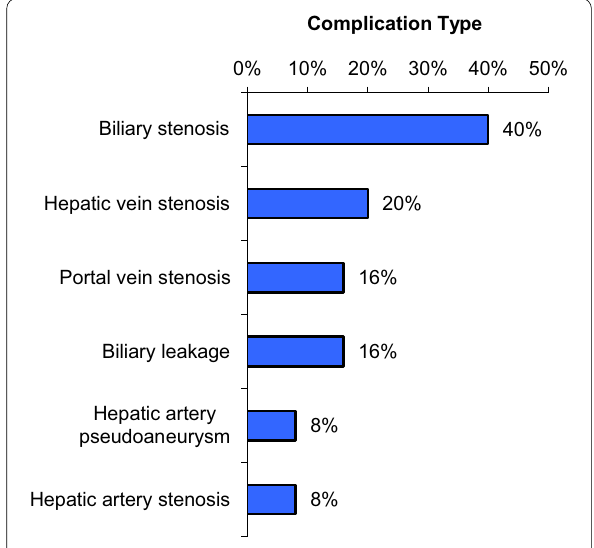
Fig. 1 Percentage of complication type in our study